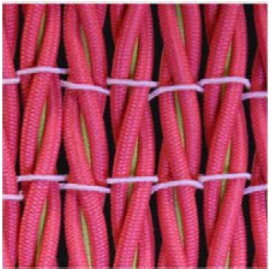
Figure 22. Fabric F12 stretched at a strain of 0.4.